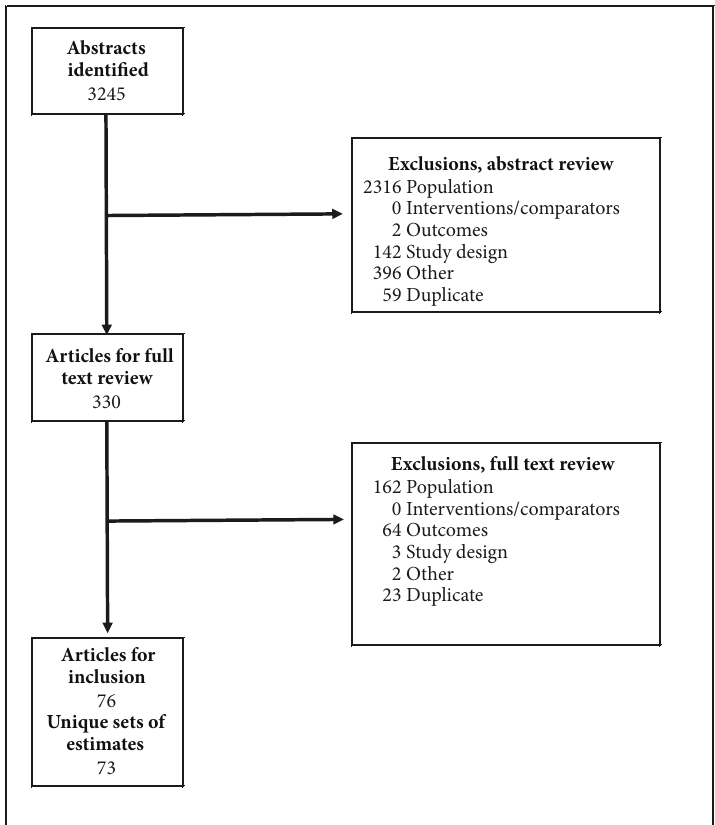
Figure 1: Flow chart of article screening and selection